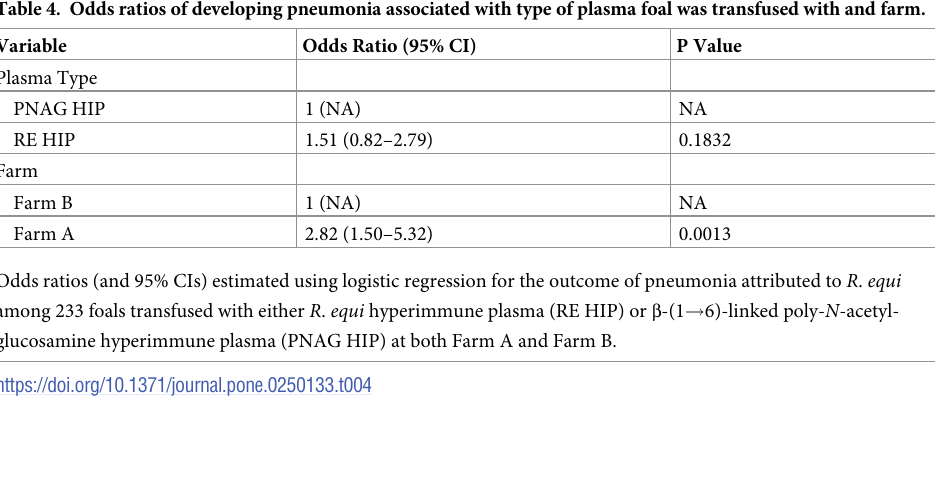
Table 4. Odds ratios of developing pneumonia associated with type of plasma foal was transfused with and farm. Variable